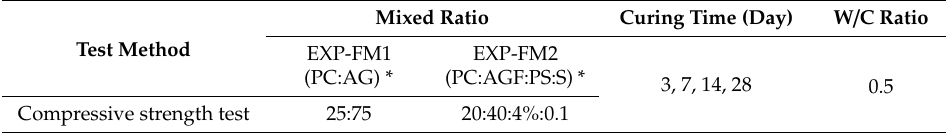
Table 5. Test condition of substitute materials with